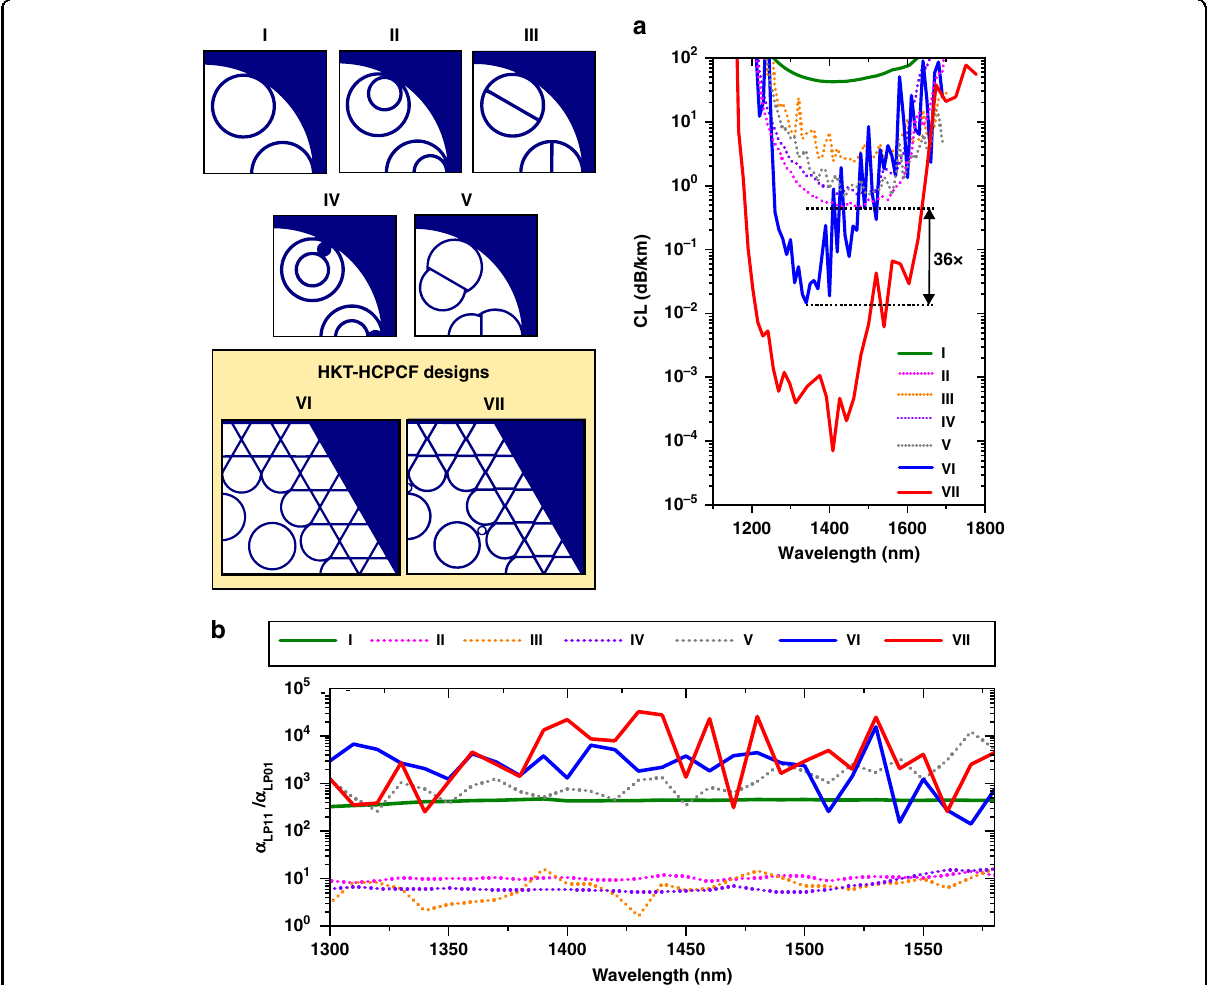
Fig. 4 Hybrid Kagome-tubular HCPCF versus reported HCPCF designs. a Fundamental mode CL simulation results for the (I) tubular, (II) nested tubular, (III) straight-bar tubular, (IV) nested-rod tubular, (V) conjoined tubes, (VI) ideal hybrid and (VII) hybrid with supporting tube fi bre designs. b The ratio between the LP 11 mode and fundamental mode CL values ( α LP11 / α LP01 ) in the studied fi bre